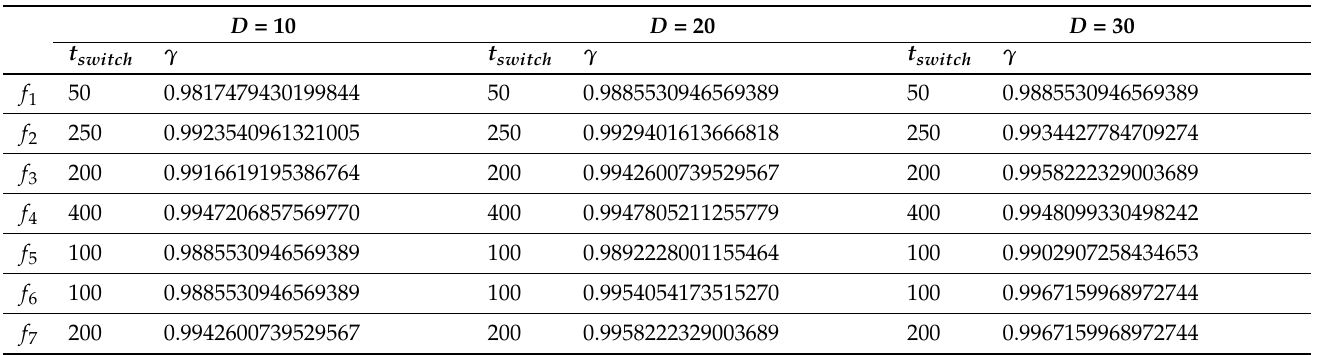
Table 2. BSO–CAPSO hybrid parameter values per benchmark